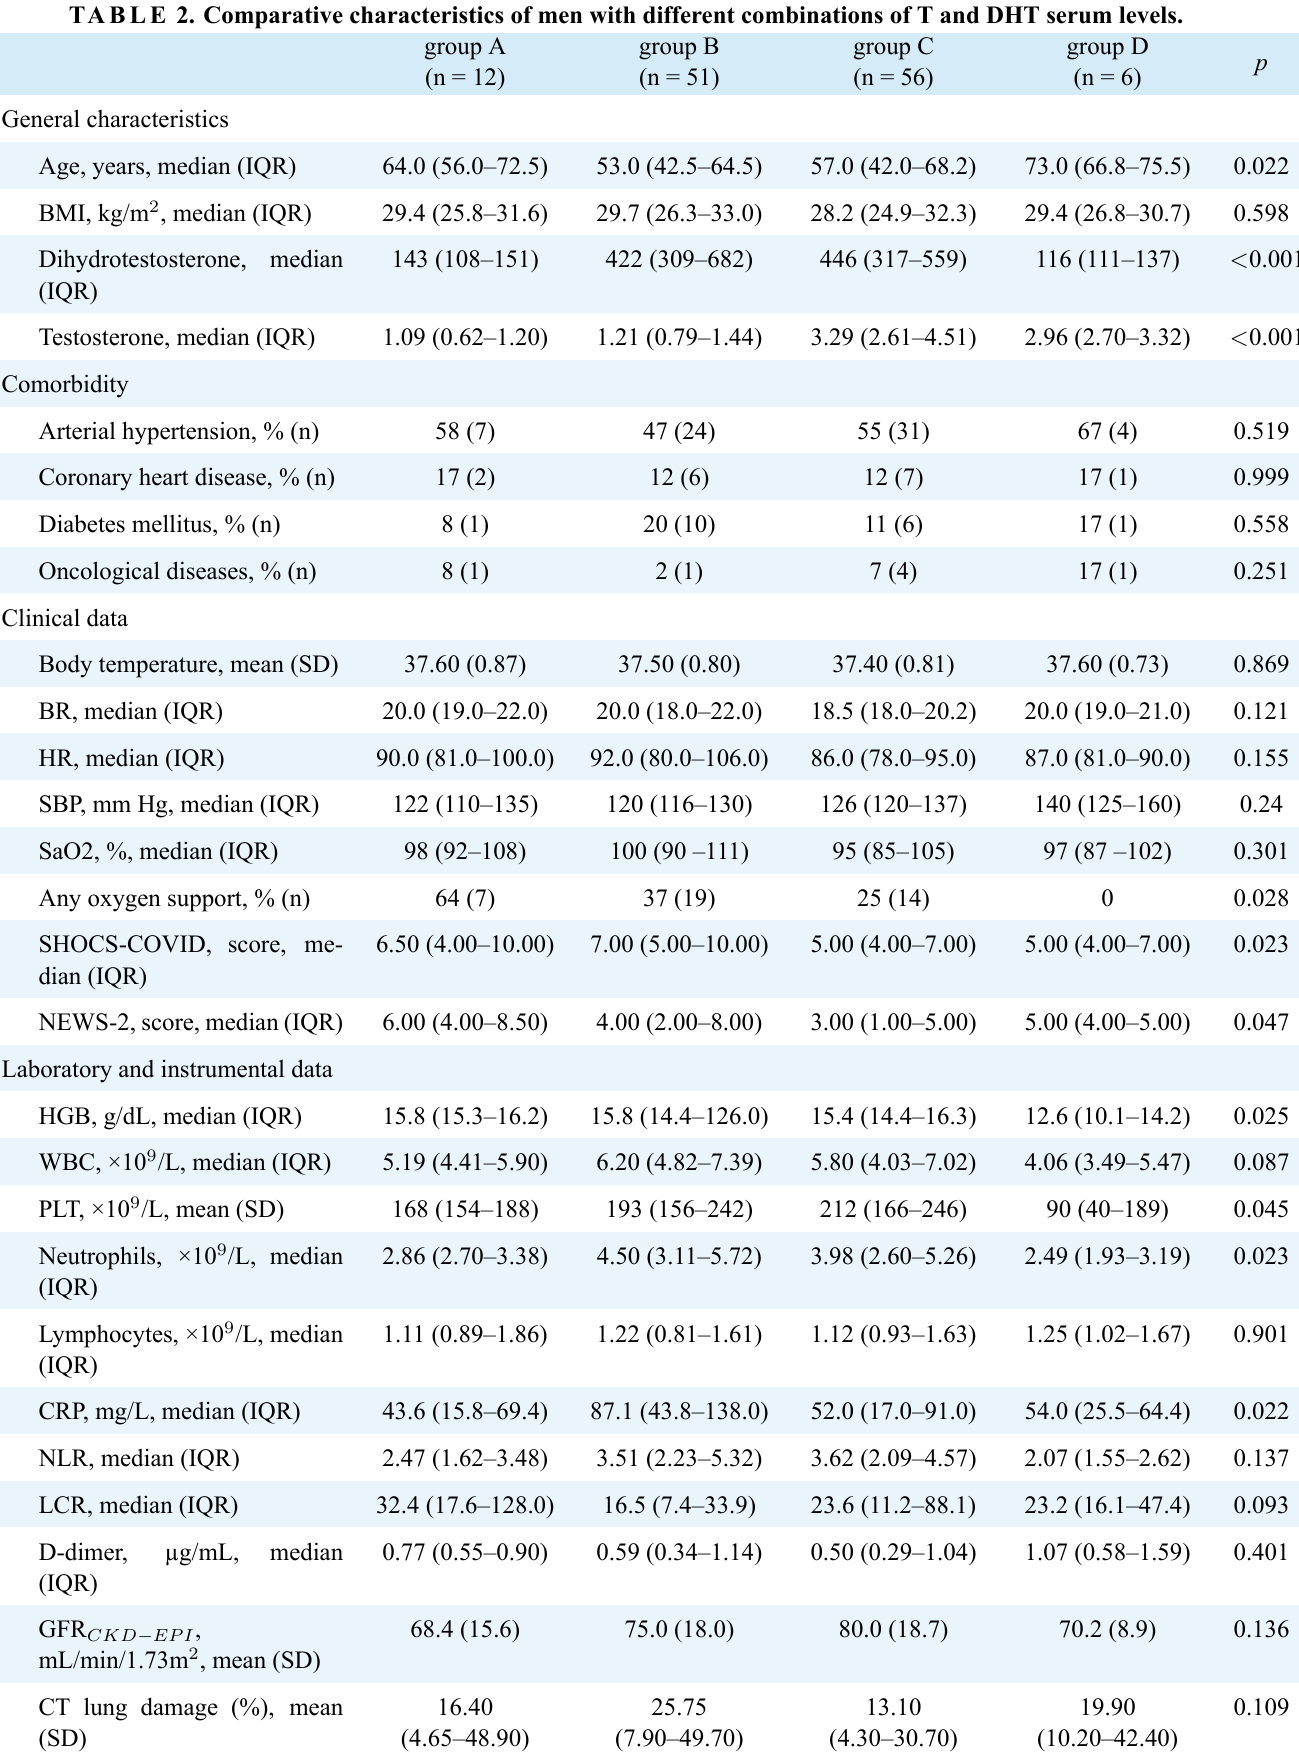
TABLE 2. Comparative characteristics of men with different combinations of T and DHT serum